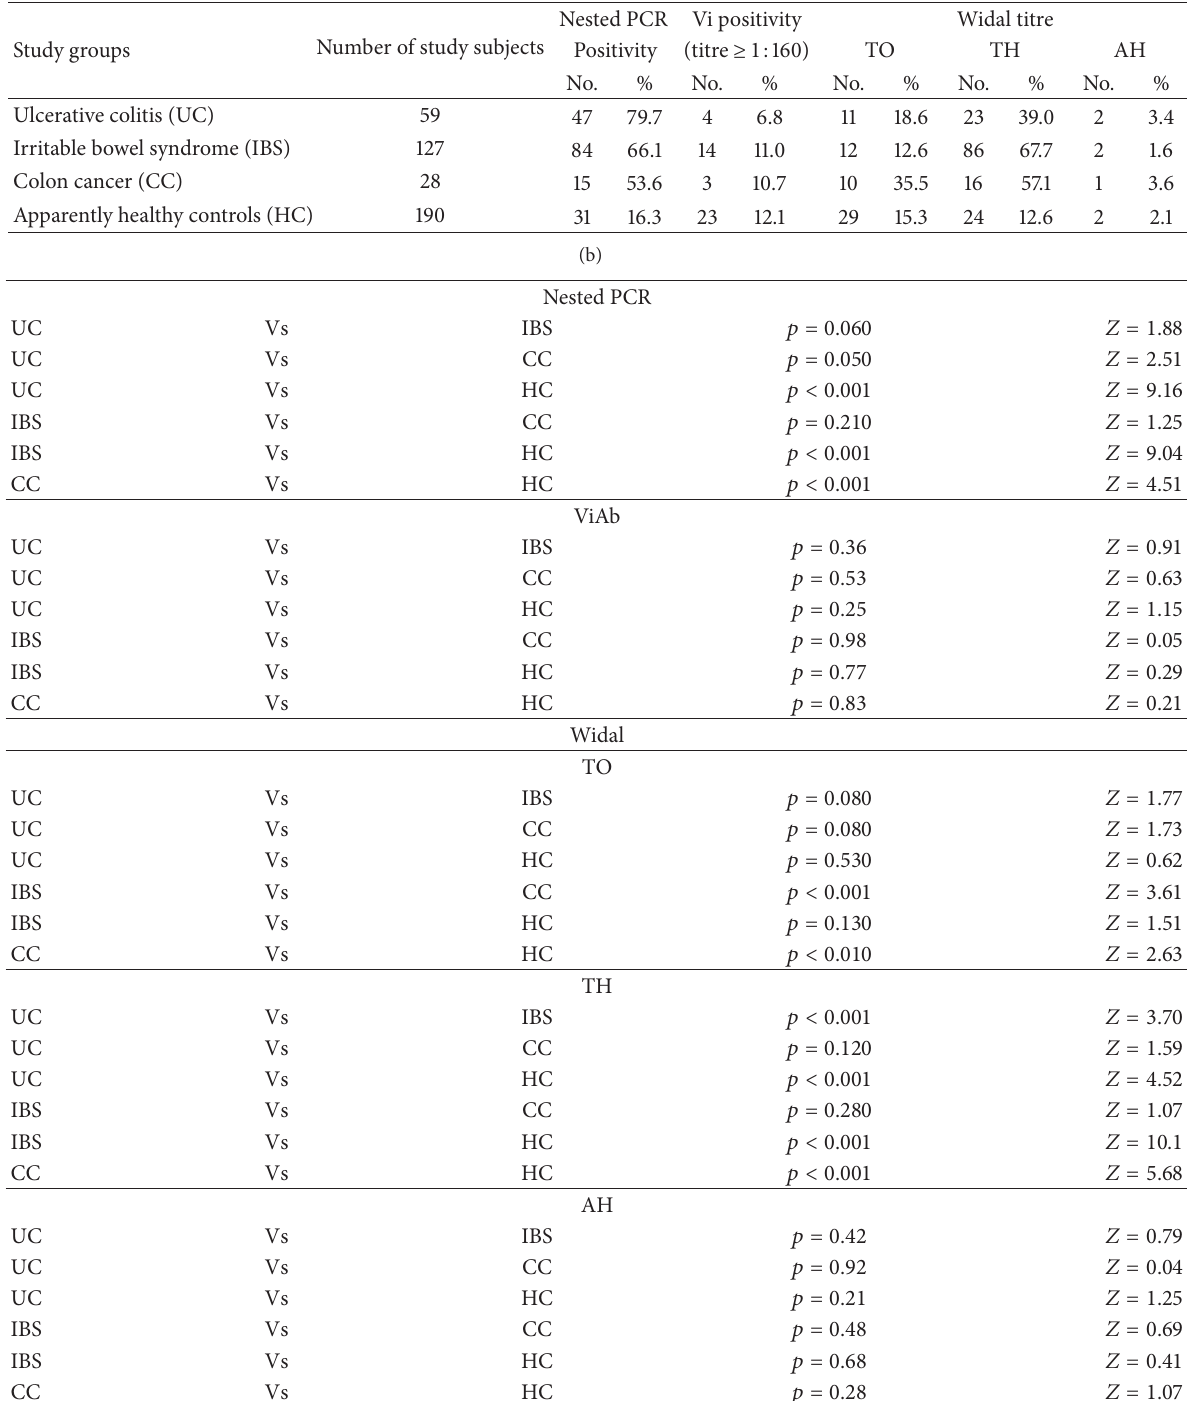
Table 2: Positivity for Salmonella Typhi and Paratyphi A by Widal test, Vi antibody, and nested PCR methods in the study population. (a) Nested PCR Vi positivity Widal